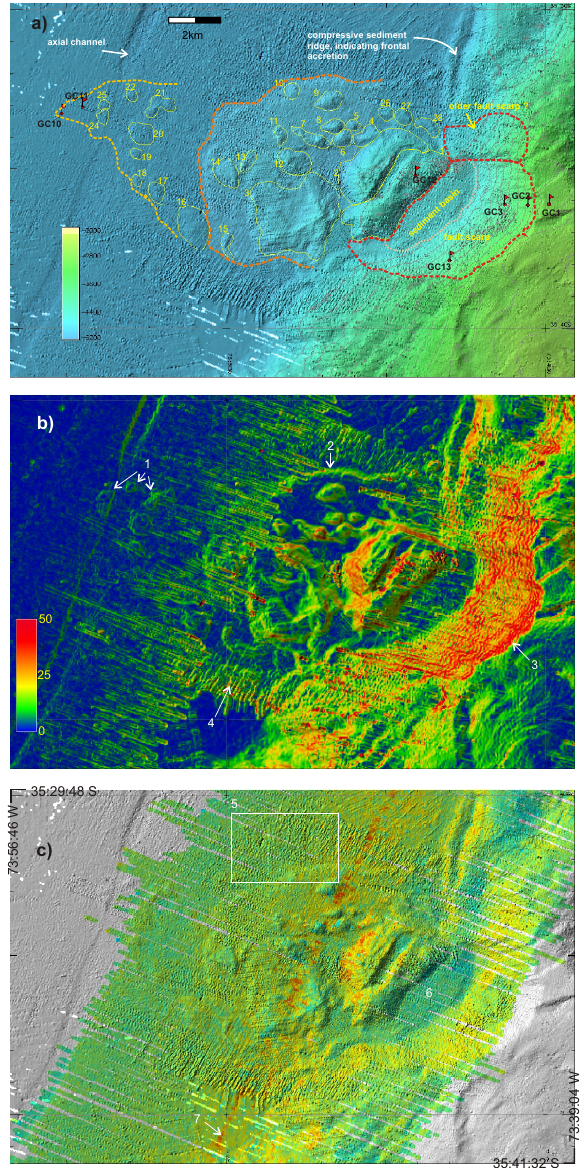
Table 1. Dimensions and elevation of the blocks composing Reloca Slide.